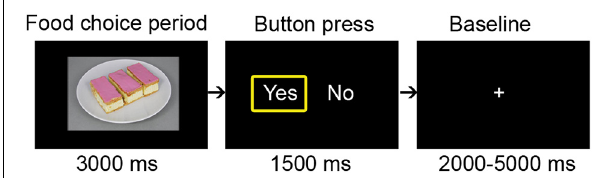
FIGURE 1 | Single food choice task trial